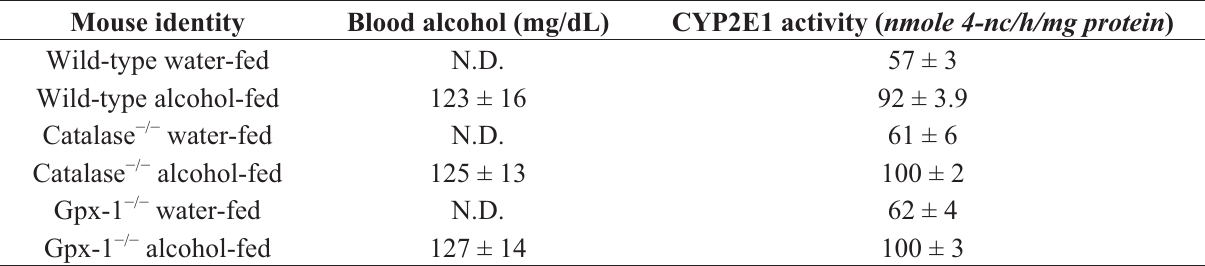
Table 1. The levels of blood alcohol and liver CYP2E1 enzyme activity in wild-type and knockout mice were measured, as described in the experimental section. (N.D. = not